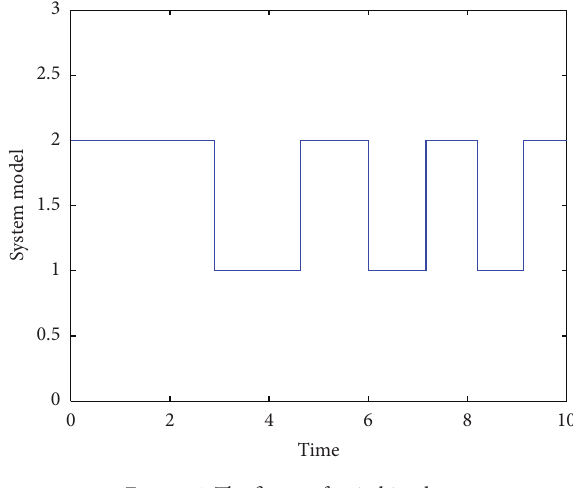
Figure 1: The figure of switching law.